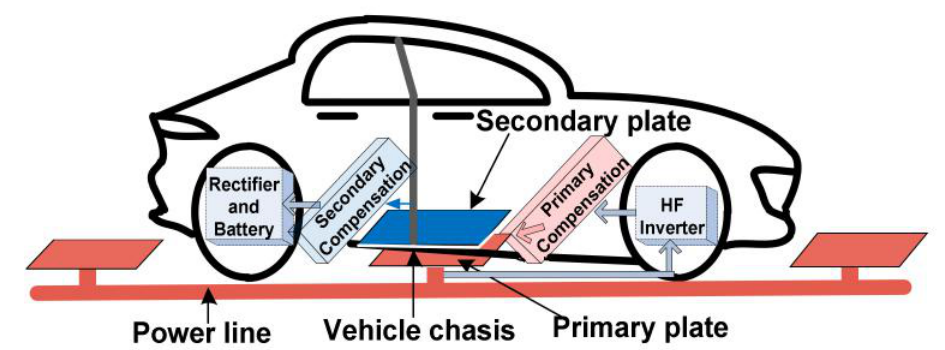
Figure 2. Block diagram for transverse capacitive charging technique in